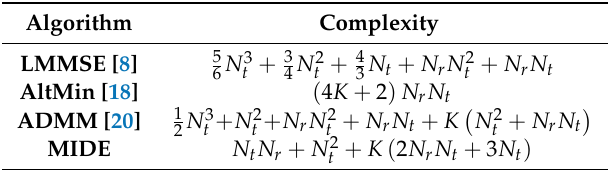
Table 1. Complexity comparison in terms of complex multiplication operations. LMMSE, linear minimum mean squared error; AltMin, alternating minimization; ADMM, alternating direction method of multipliers; MIDE, modified iterative discrete estimation.